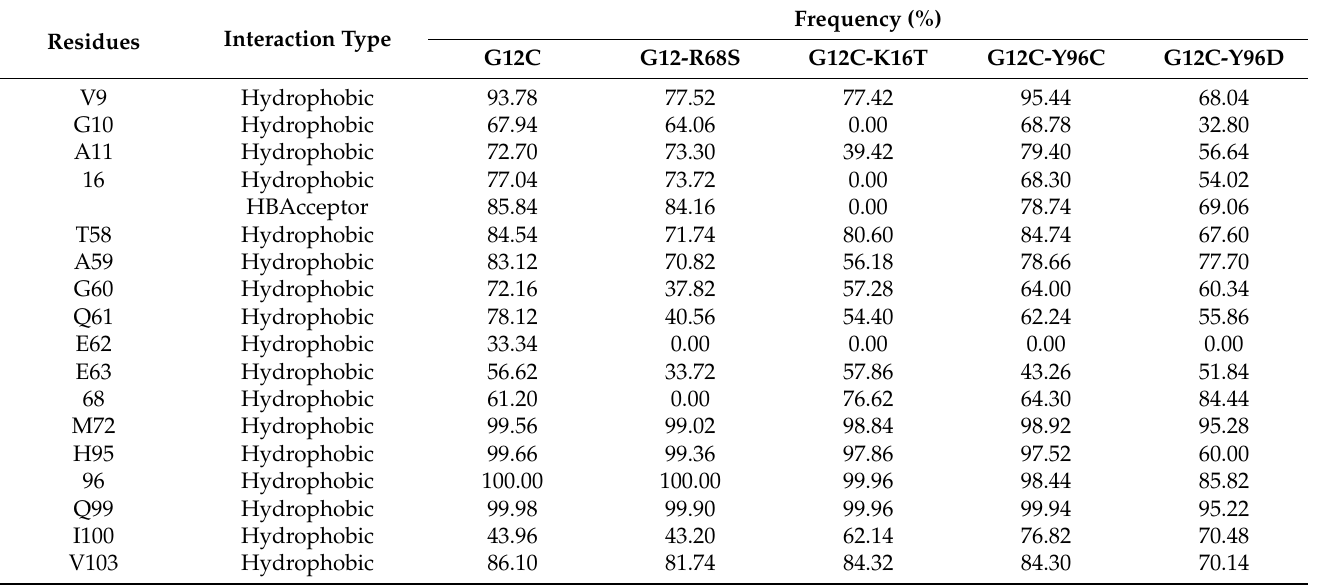
Table 3. Fingerprints of molecular interaction including the interaction types between AMG510 and mutant KRAS protein.